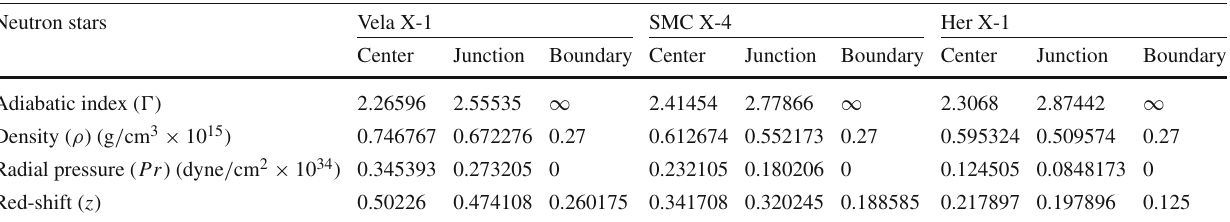
Table 2 The variation of physical parameters, i.e., adiabatic index, density, radial pressure and red-shift for three well-known neutron stars i.e. (i) Vela X-1 (ii) SMC X-4 and (iii) Her X-1 for the values of G = 6 . 67 × 10 − 11 m 3 kg − 1 s − 2 , M (cid:2) = 2 × 10 30 kg and C = 3 × 10 8 ms − 1 Neutron